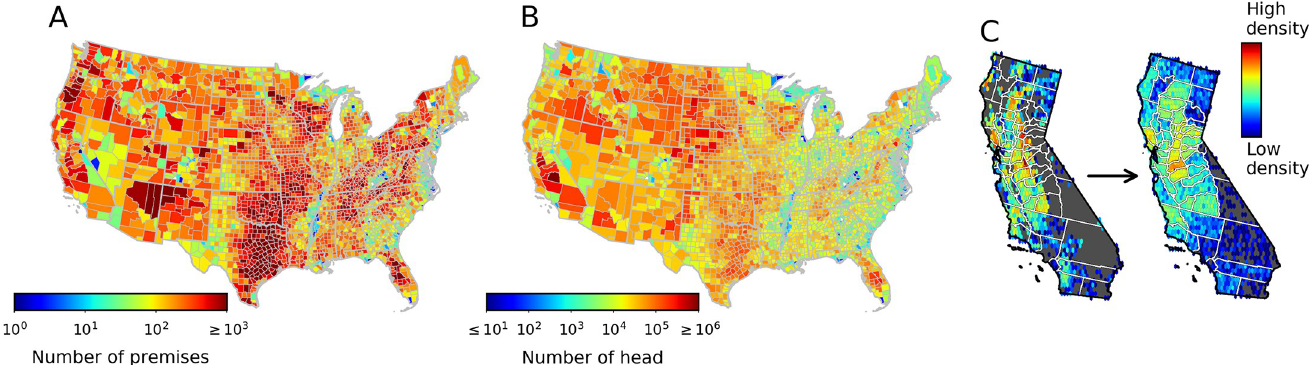
Fig 1. Spatial distribution of premises (A) and head (B) at the county level of the U.S. cattle population based on NASS [13,14] data common to all ten FLAPS realizations. Using California as an illustrative example, panel C shows how location randomization within counties (right) changes the spatial distribution of premises relative to the realistic assumptions used in FLAPS